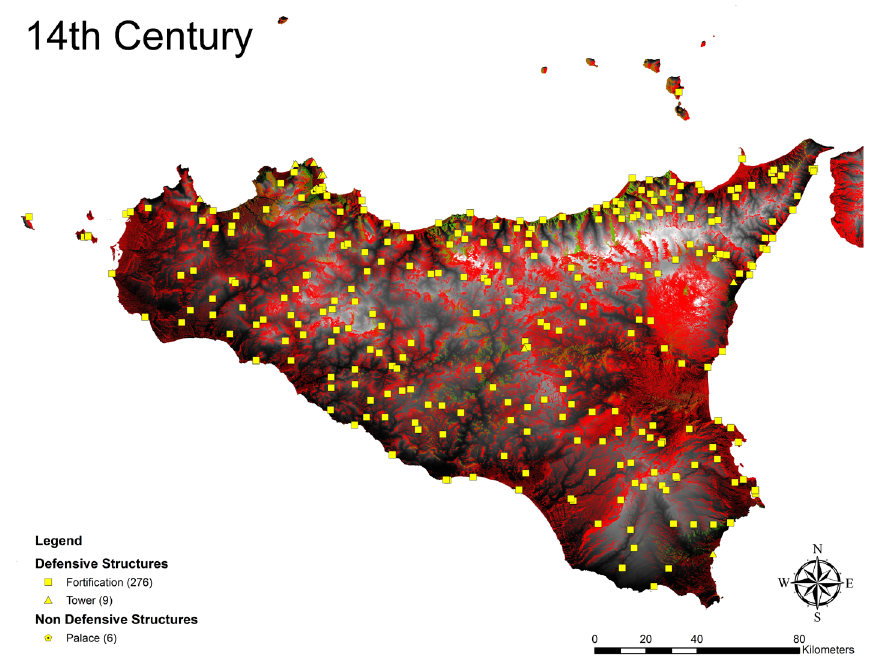
Figure 5. Figure showing the distribution of defensive structures and their viewsheds in the 14th century. Fortifications are represented by squares and the area they have surveillance over is in red whereas towers are represented by triangles and the area they have surveillance over is in green. Also included are palaces represented by hexagons. Image derived from an ASTER GDEM (a product of NASA and